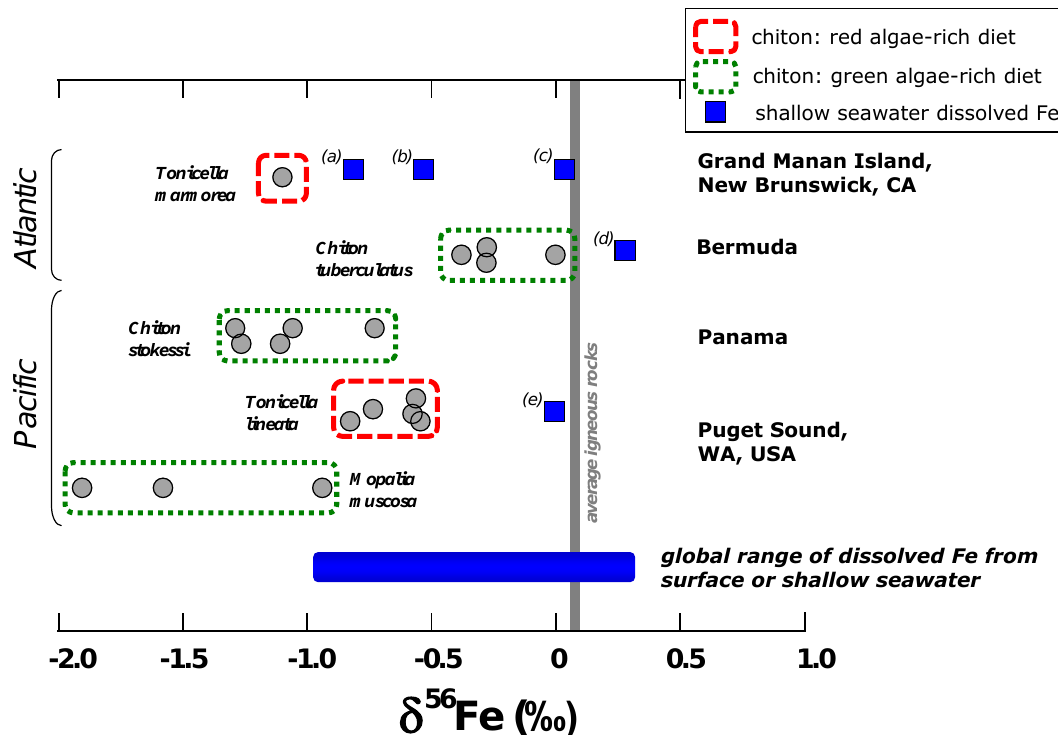
Figure 2. Fe isotope signatures of 18 chiton teeth analyses (grey circles). Analytical uncertainties in δ 56 Fe are smaller than the symbols. Data points encircled by the red dashed lines indicate chitons with a red-algae-rich diet, while green dotted lines indicate a predominantly green algae diet. Note that the values for the chitons with a red-algae diet from Washington cluster close together; by contrast, chitons from the same location with a diet of green algae have a larger variance and a lighter isotopic signature. The single value for Tonicella marmorea from Grand Manan Island represents the average of eight homogenized specimens. For comparison, the average for igneous rocks (Beard et al., 2003) is indicated by the vertical grey line, while the range of Fe isotope values reported in the literature for dissolved Fe in surface and shallow (<75m depth) seawater (Lacan et al., 2008, 2010; John and Adkins 2010, 2012; Rouxel and Auro, 2010; Radic et al., 2011) is represented by the solid blue band at the bottom. Blue squares are published surface seawater isotope analyses of dissolved Fe from locations as close to the chiton sampling sites as available data permit. Data reported by Rouxel and Auro, (2010) for three sites located off the northeastern Atlantic coast of North America are (a) Vineyard Sound on Cape Cod, Massachusetts, USA ( − 0.82‰); (b) Waquoit Bay on Cape Cod, Massachusetts, USA ( − 0.55‰); and (c) Connecticut River estuary in Long Island Sound, Connecticut, USA ( + 0.04‰). These three sites are located within less than 150km distance from each other, on average about 500 km south of the chiton sampling site at Grand Manan Island, New Brunswick, CA). Data for the North Atlantic (d) ( + 0.3‰; sampled about 100km southeast from Bermuda; John and Adkins, 2010; John and Adkins, 2012) are compared with the Bermuda chiton sampling site. The closest available coastal seawater Fe isotope data to compare with the Puget Sound chiton sampling site (Washington, USA) is from the San Pedro Basin (e) (0‰; John and Adkins, 2010), which is located off the Atlantic coast near Los Angeles (California, USA), about 1500km south of Puget